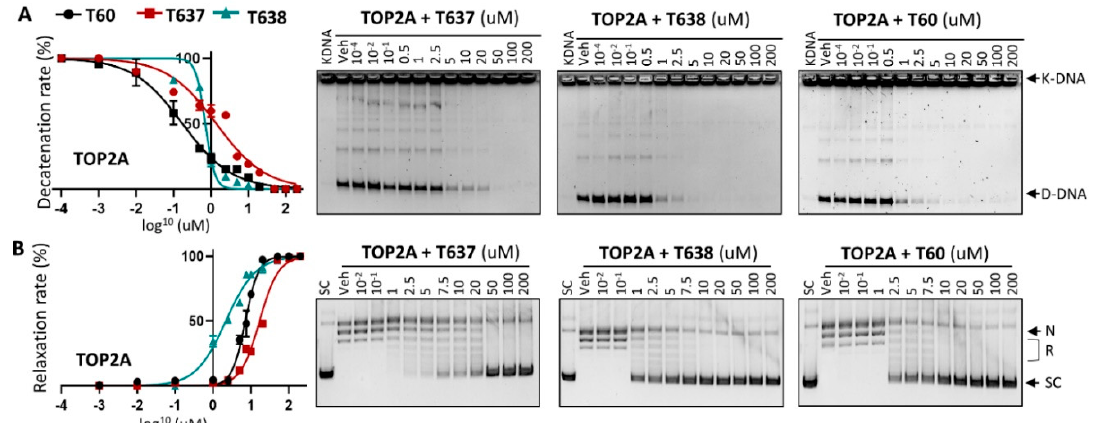
Figure 2. T637 and T638 are TOP2A inhibitors. ( A ) K-DNA decatenation assays and ( B ) supercoiled plasmid DNA relaxation assays are used to measure TOP2A enzyme activity in the presence of 0.01–200 uM T637 or T638. Three biological repeats were performed with each concentration of the compounds, and the densitometry of the D-DNA bands from ( A ) and the SC bands from ( B ) was used to establish an inhibition curve for IC 50 calculation.